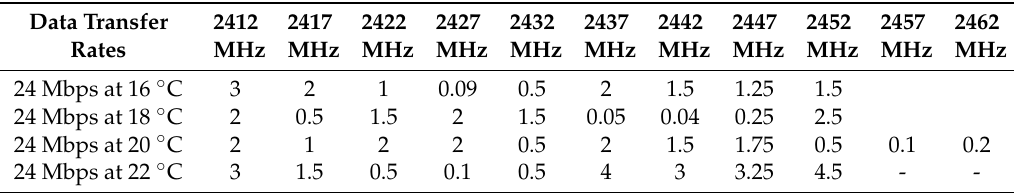
Table 16. Calculation of residuals for OFDM at 24 Mbps.